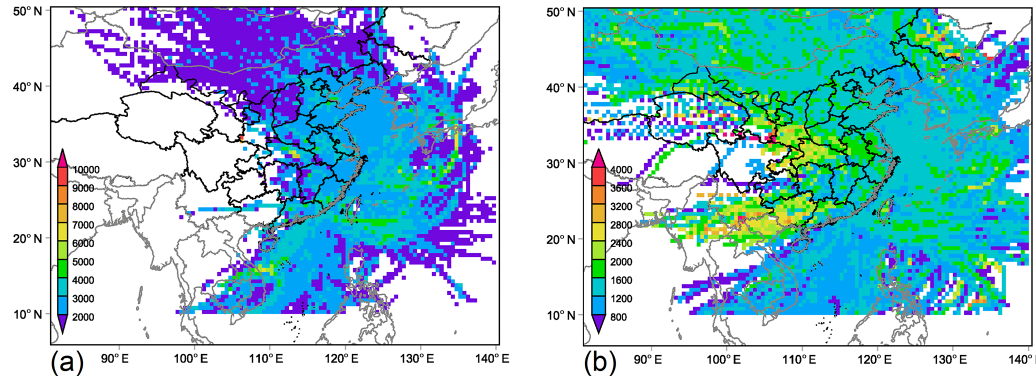
Figure 8. Concentration-weighted trajectory (CWT) maps (ngm − 3 ) for (a) BC ff and (b) BC bb in Xiamen in 2014.